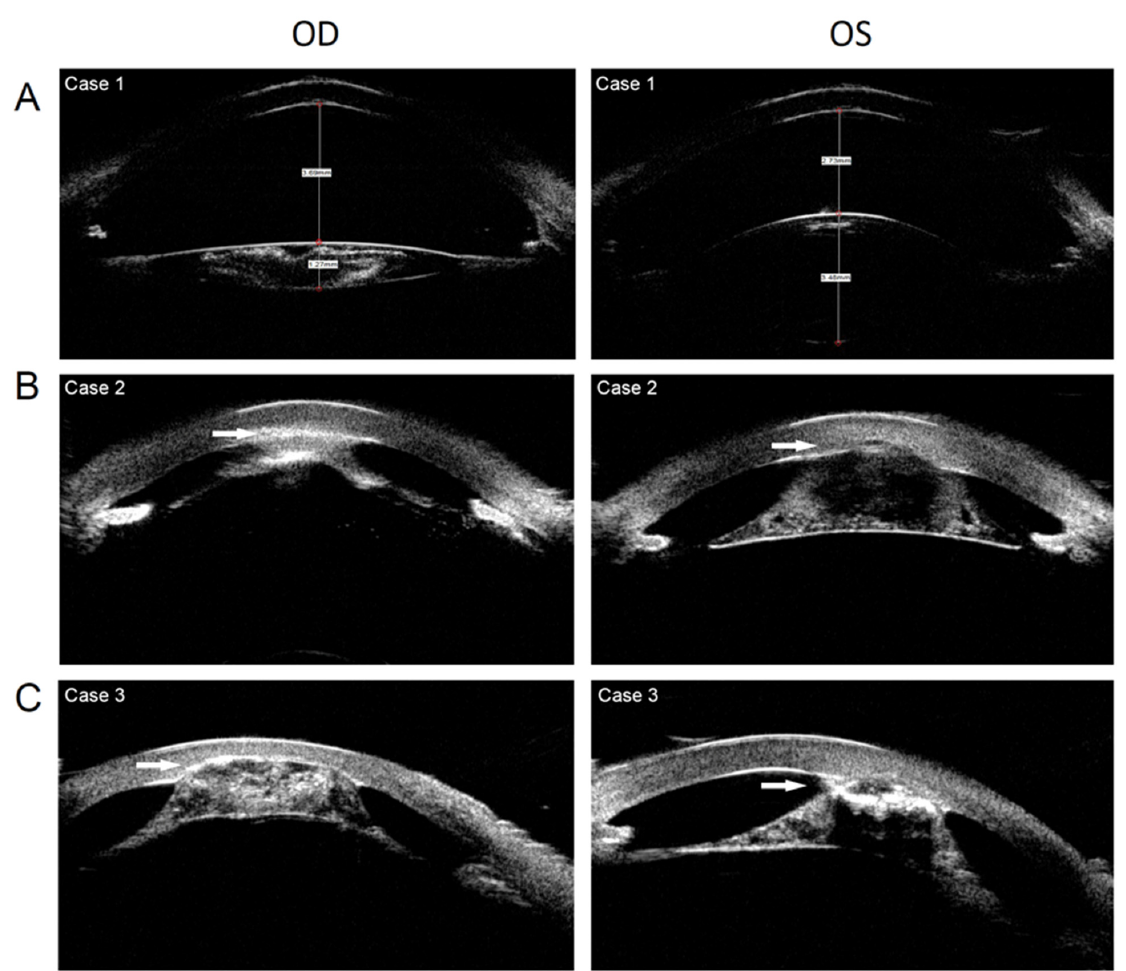
showing keratolenticular adhesion, corneal neovascularization, aniridia, and cataract. ( D ). Anterior segment of case 3 showing keratolenticular adhesion, corneal neovascularization, aniridia, and the thin lens with cataract. ( E ). Anterior segment of case 4 showing keratolenticular adhesion, corneal neovascularization, aniridia, and the cataract. ( F ). Anterior segment of case 5 showing nuclear cataracts and aniridia. ( G ). Anterior segment of case 6 showing subcapsular cataract and aniridia. (White arrow: keratolenticular adhesion; red arrow: corneal neovascularization.).